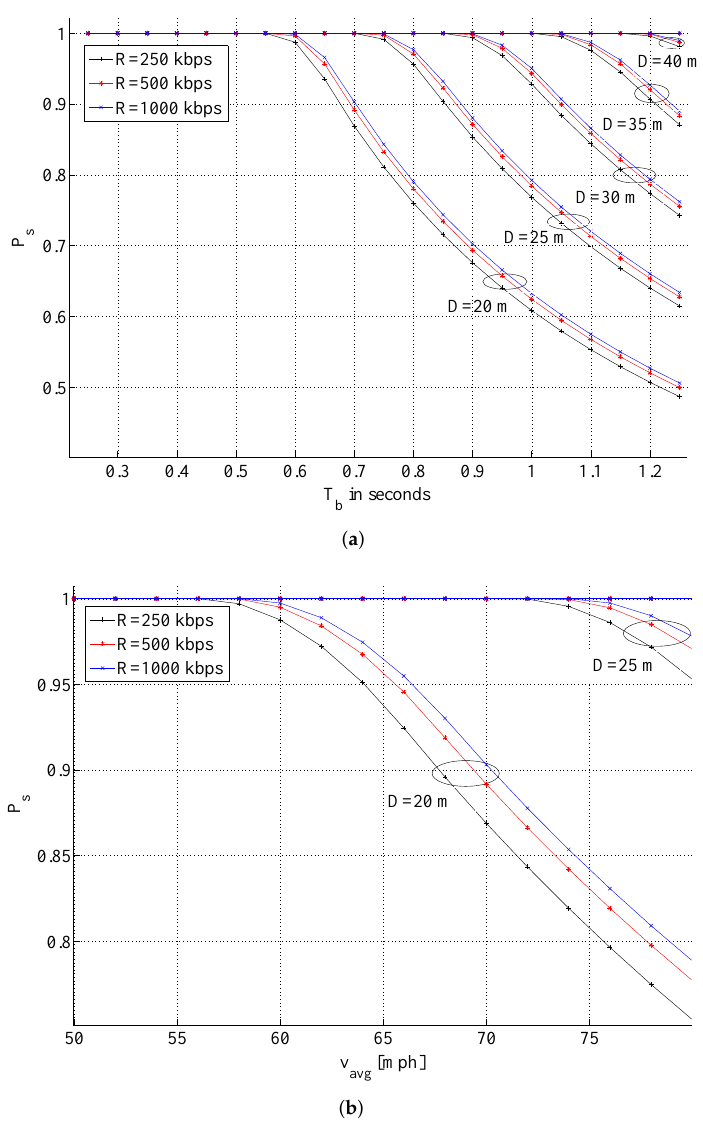
Figure 4. Illustrating P success for various data rates R and coverage distances D . ( a ) Varying beacon interval with v avg = 70 mph, ( b ) Varying average vehicle speed with T b = 0.7